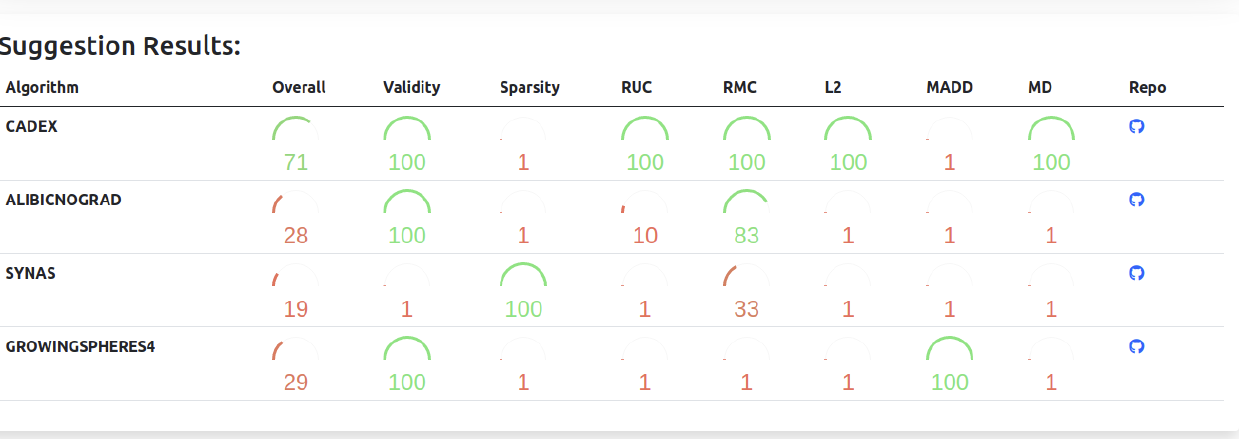
Figure 9. Proposed user interface to the suggestion system which tells the best performing algorithms for a specific dataset setting. The scores are calculated by using decision trees and reflect how well (compared to the others) the algorithm